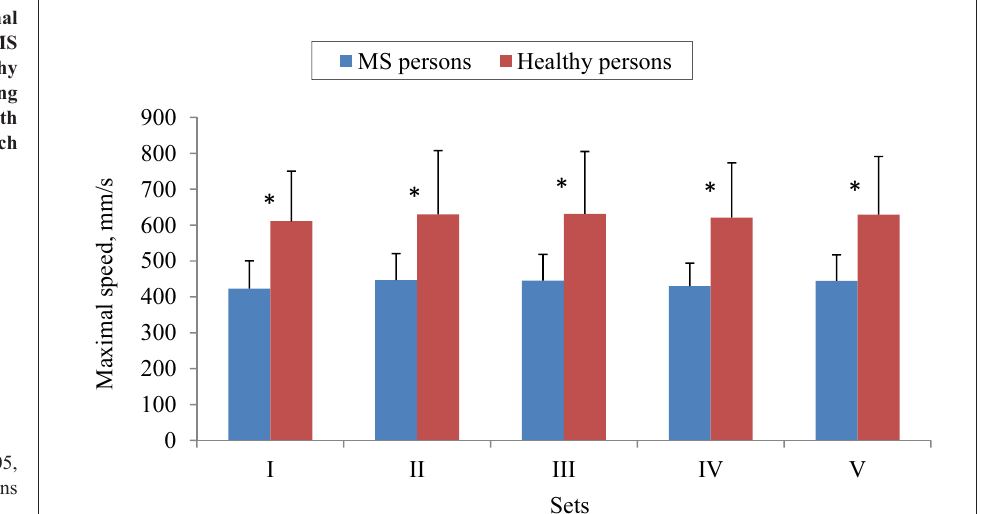
Figure 2. Mean values of average speed (mm/s) for MS persons and healthy persons Figure 3. Mean values performing the task – five sets with 20 repetitions in each set